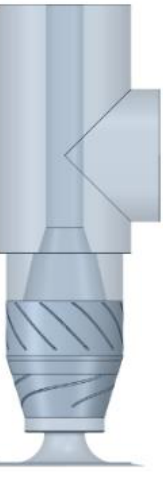
Figure 1. Circulating pump structure.